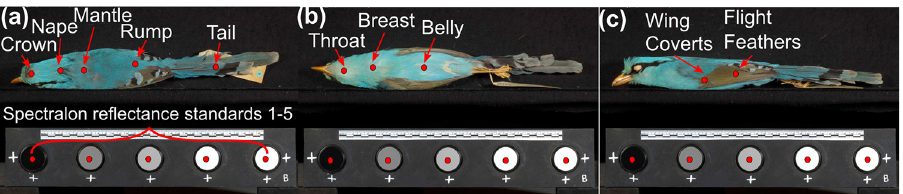
Fig 1. Examples of points on the avian specimen images. (a) Five reflectance standards and five body regions (crown, nape, mantle, rump and tail) of the back view; (b) Three body regions (throat, breast and belly) of the belly view; (c) Two body regions (wing coverts and flight feathers) of the side